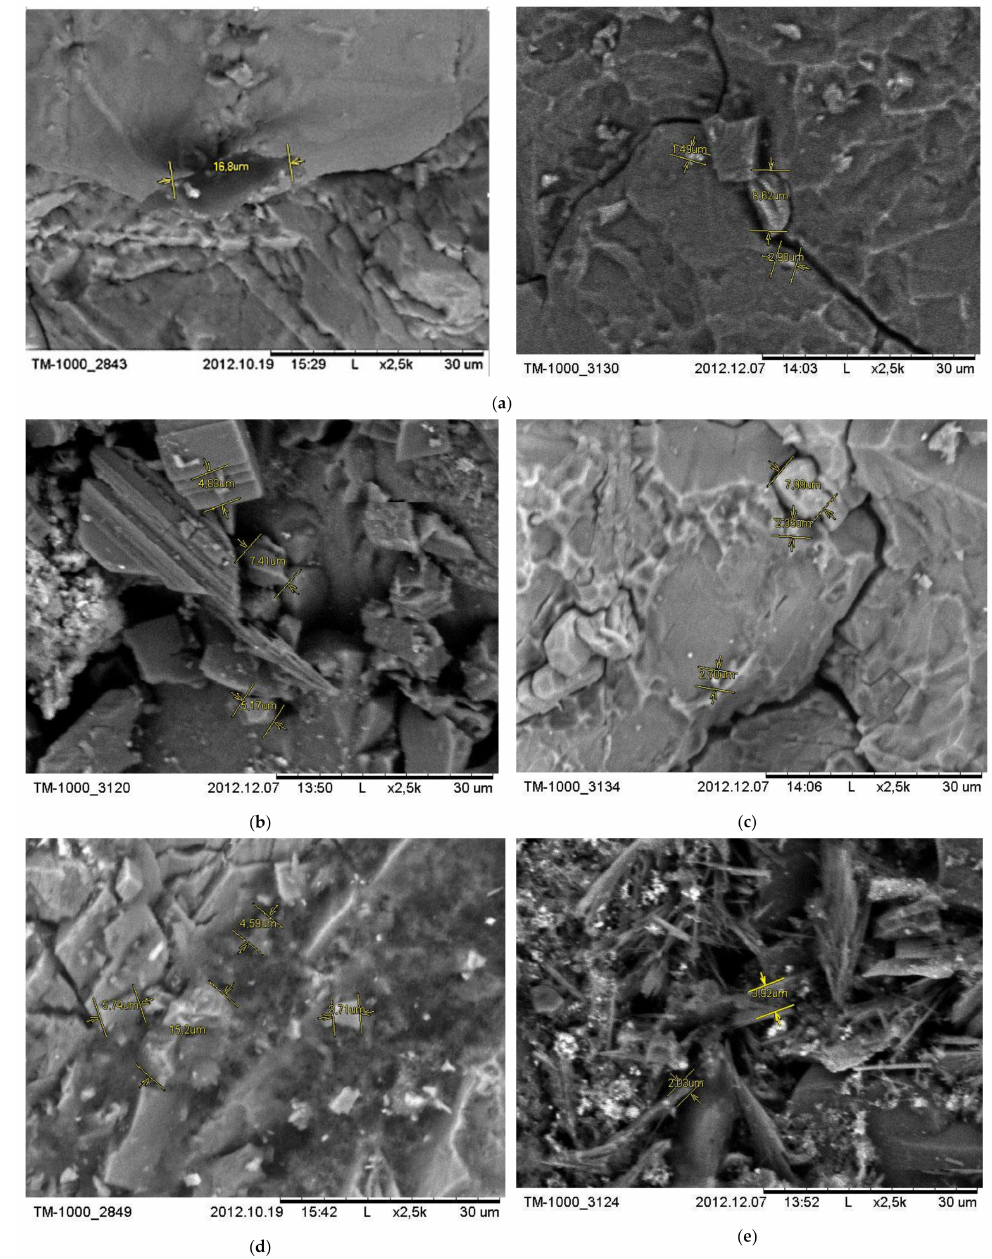
Figure 9. Microstructure of carbonate: ( a ) before and after experiments: ( b ) 1—oil, water, Al 2 O 3 , carbonate; ( c ) 2—oil, water, carbonate; ( d ) 4—oil, water, Al 2 O 3 , carbonate; ( e ) 6—oil, water, C 6 H 8 O 7 ,